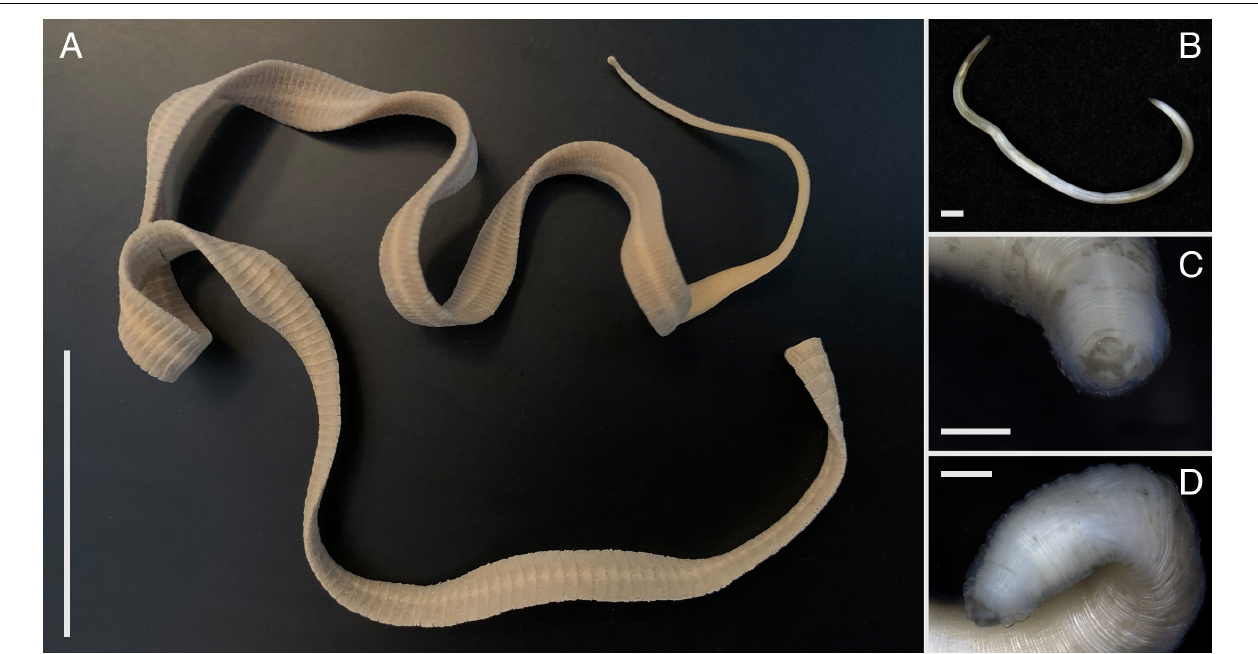
FIGURE 3 | Helminths isolated out of Otaria flavescens feces: (A) cestode Adenocephalus pacificus , (B–D) specimes of Anisakidae nematodes. Scale bars: (A) 4 cm, (B) 1 mm, (C,D) 500 µ m.